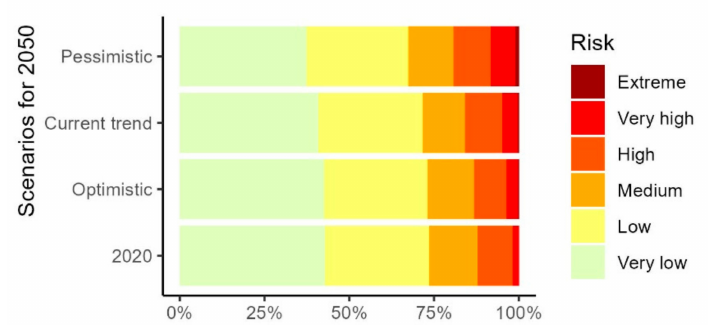
Figure 2. Proportion of existing hydropower projects in basins with different classes for risk of water scarcity currently (2020) and in 2050 under three scenario pathways: optimistic, current trend, and pessimistic.